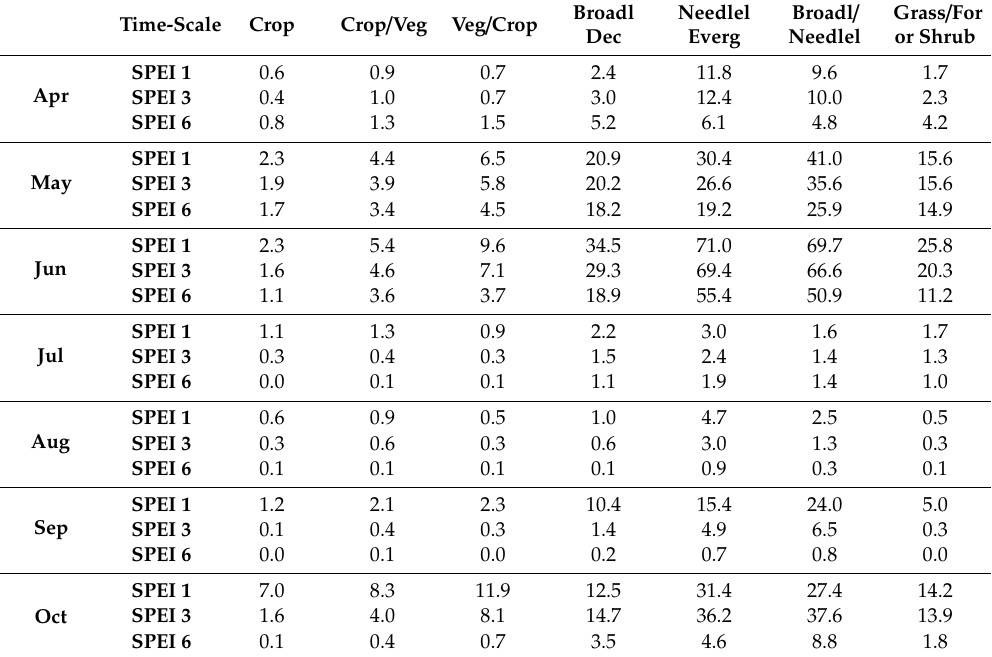
Table 5. Percentage area of each land cover class presenting significant negative correlations between NDVI and SPEI, for the months from April to October and time scales of 1, 3 and 6 months. Only land cover classes covering more than 1% of the area are shown. Time-Scale Crop Crop / Veg Veg / Crop